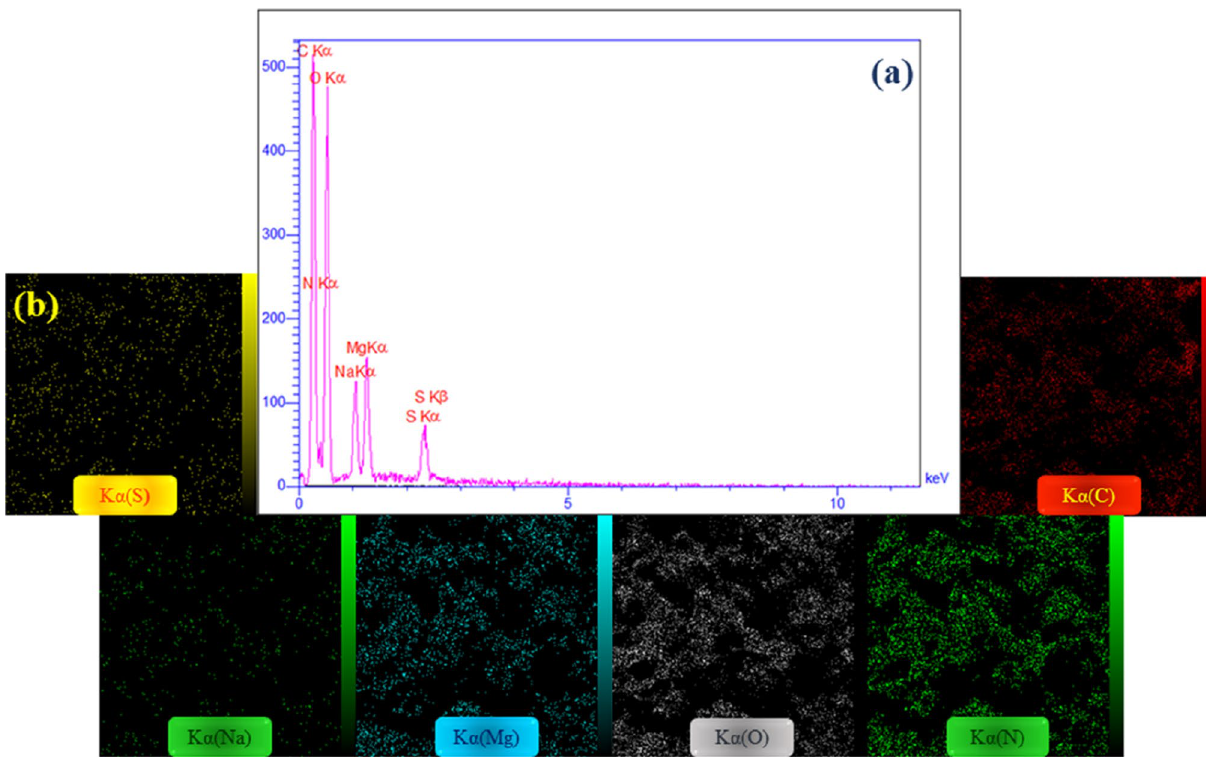
Figure 3. ( a ) EDX spectrum, ( b ) elemental mapping images of CTT-CS/SF/Mg(OH) 2 nanobiocomposite scaffold.